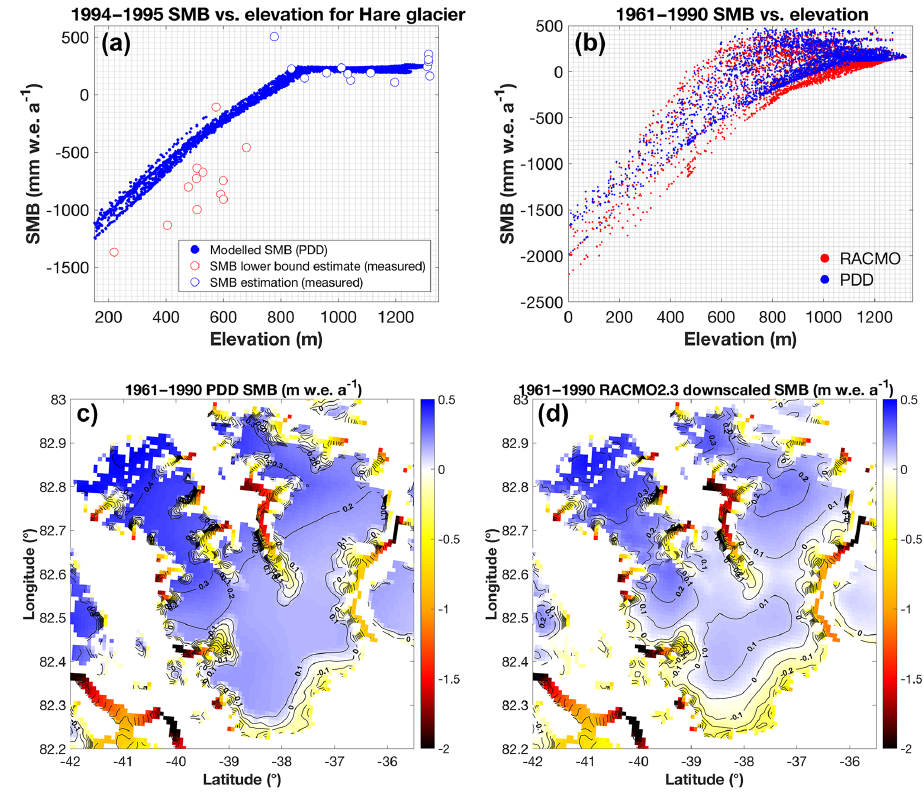
Figure 4. (a) 1994–1995 SMB for Hare glacier based on the PDD melt–runoff model and SMB measurements (lower-bound estimate in the ablation area; see text). (b) SMB vs. elevation for the period 1961–1990 for the PDD melt–runoff model and RACMO 2.3. Average SMB for the period 1961–1990 from (c) PDD melt–runoff model and (d) RACMO2.3 RCM model. The masking and the calculations for panels (b, c, d) are based on the 1km GIMP DEM ice mask and topography (Howat et al.,